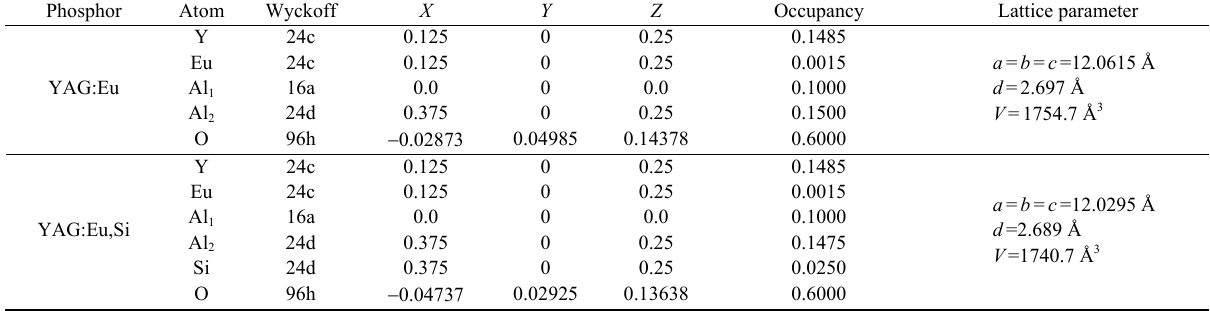
Table 2 Parameters of phosphors after Rietveld refinement